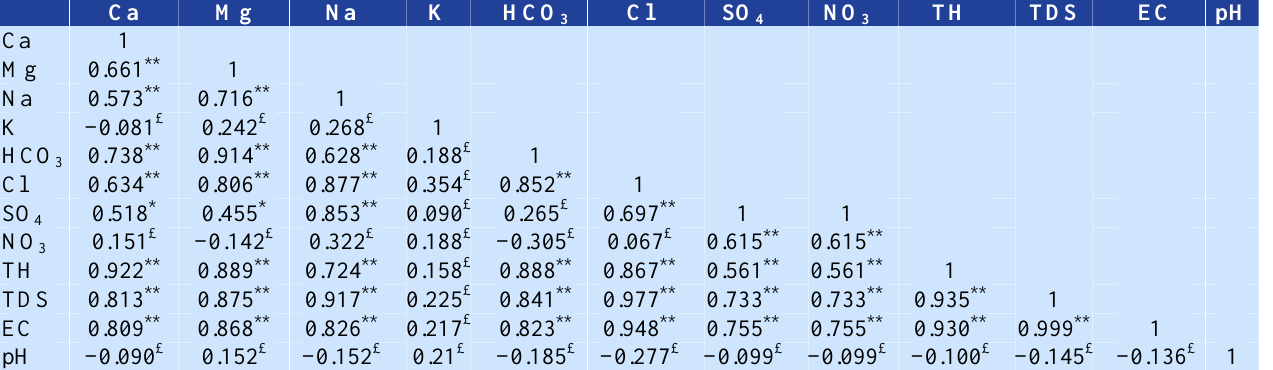
Table 4. Correlation matrix of studied water quality